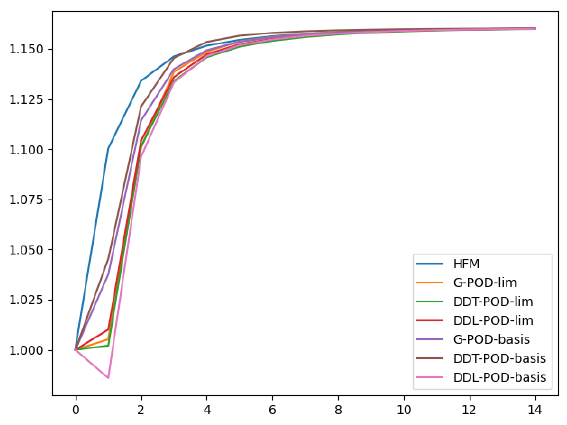
Figure 11. k eff vs. iteration number for the HFM and the three methods with limited (lim) number of snapshots or smart selection of number of basis functions.